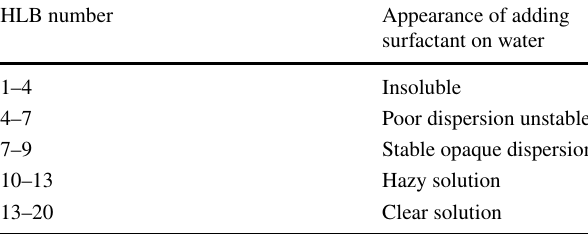
Table 2 The appearance of water depends on the HLB number (Por- ter